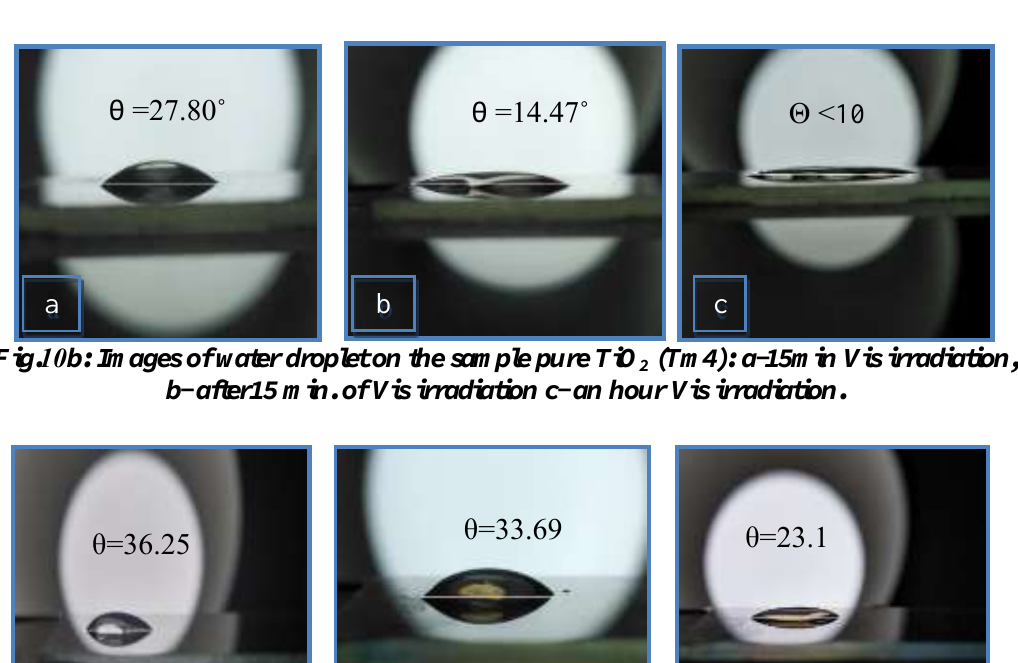
(Tm5): a-15min UV irradiation, 2